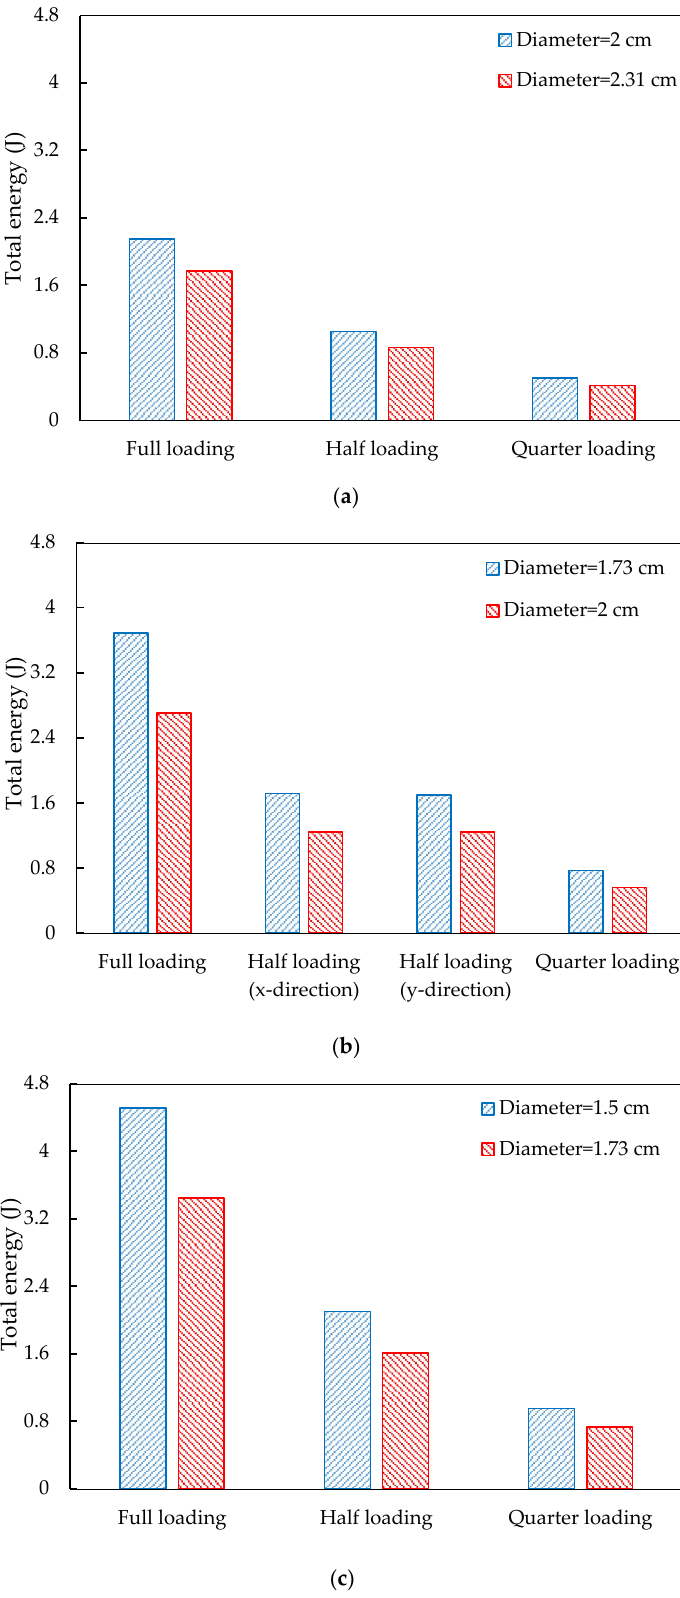
Figure 9. Total electrical energy production in the PEHs with different piezoelectric unit distribution: ( a ) 3 × 3; ( b ) 3 × 4; ( c ) 4 × 4.